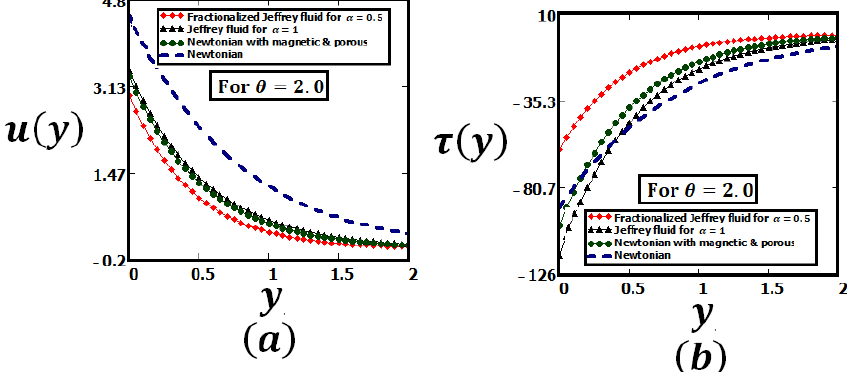
Figure 12: Profiles of the velocity field u ( y , t ) and the shear stress τ ( y , t ) for fractionalized & ordinary Jeffrey fluid given by Eqs. (16) and (21), Newtonian fluid with MHD & parous and Newtonian fluid given by Eqs. (32) and (33) for A = 1, ν = 1.427, µ = 19, λ 0.5, K = 2, α = 0.5, θ = 2, p = 4 and t = 2 s